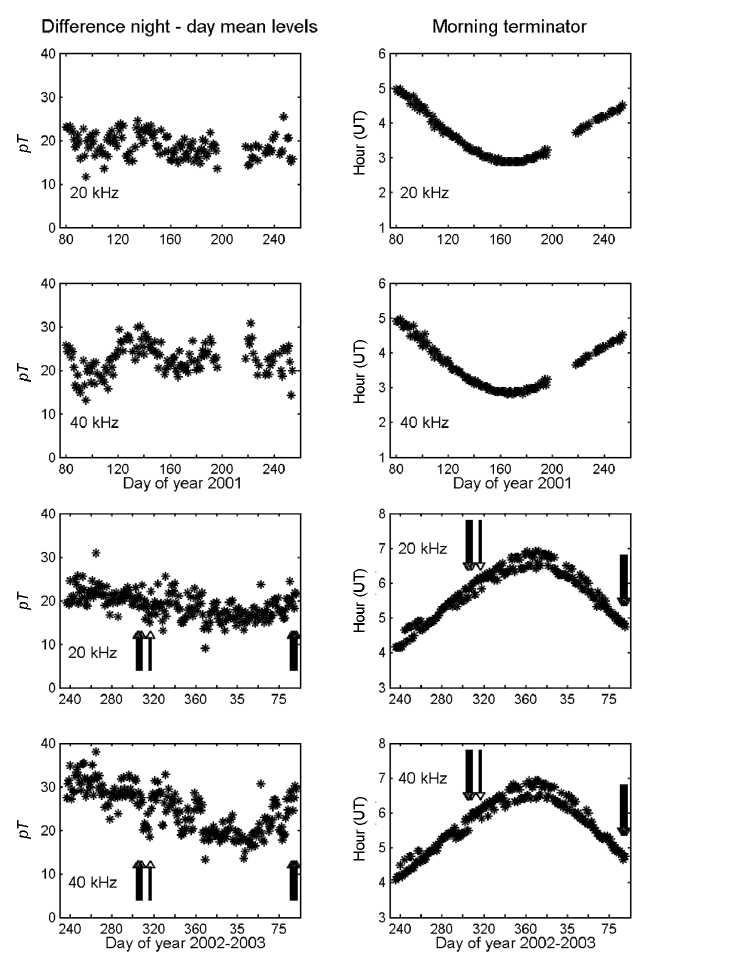
Fig. 8. Left panels: difference between the average nighttime (10-14 LT) and daytime (22-02 LT) VLF levels; right panels: morning terminator time. The arrows indicate the earthquakes ( M d >= 4)